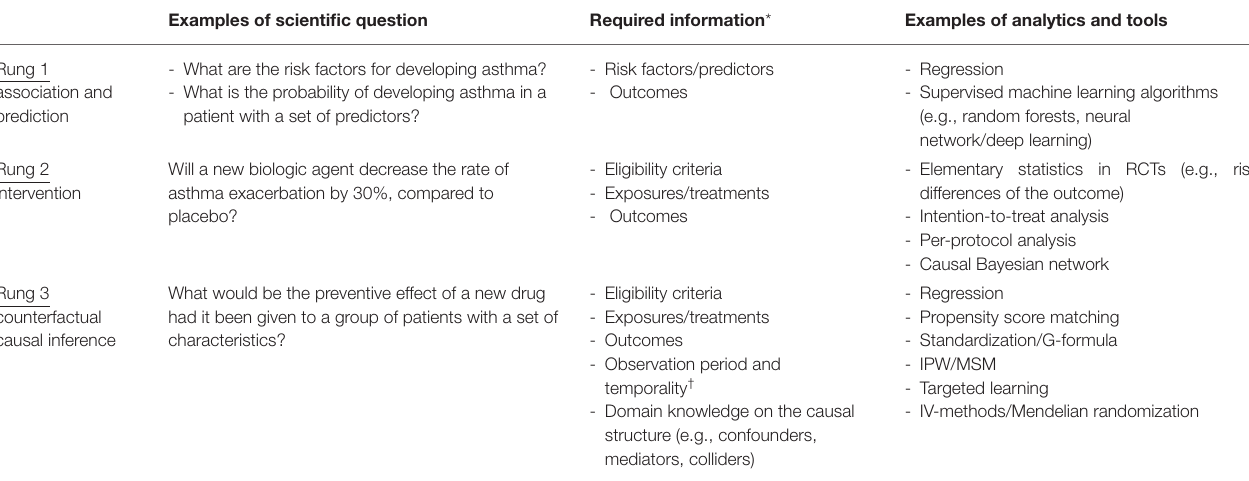
TABLE 2 | Scientific questions, required information, and analytical methods of data science according to the ladder of